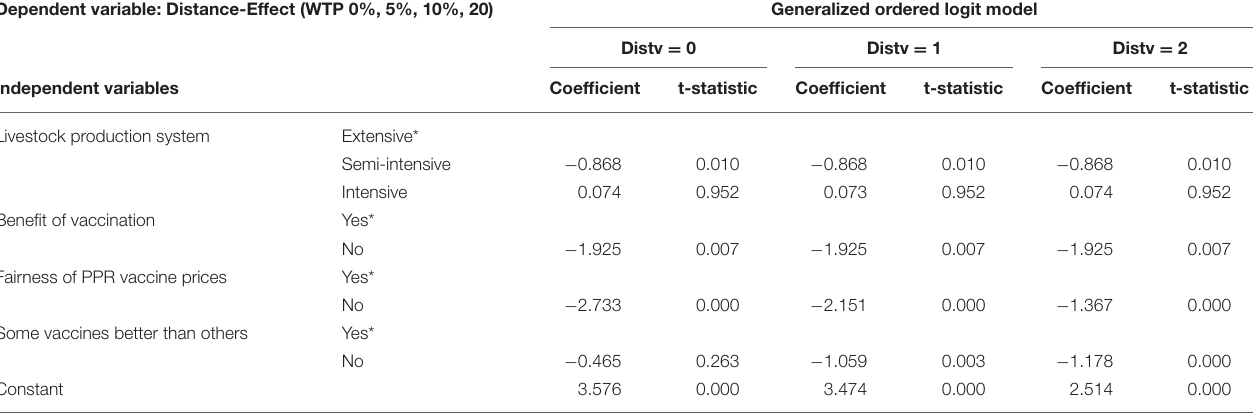
TABLE 7 | Regression analysis results for the distance-effect.